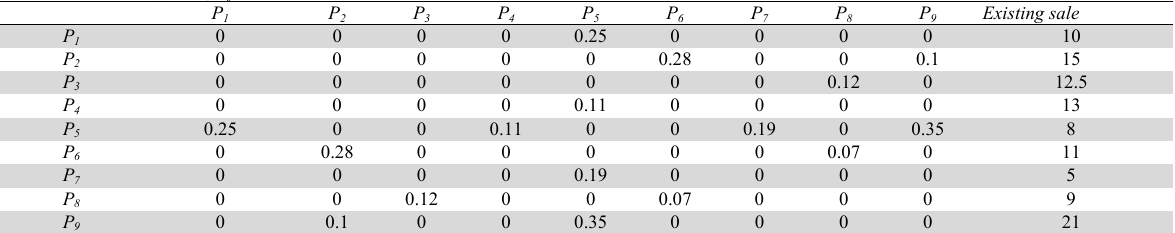
The performance data of projects in the target market and the calculated market interdependence scores of projects are shown in Table 7 and Table 8, respectively. Value matrix of synergy ij and outcome i P